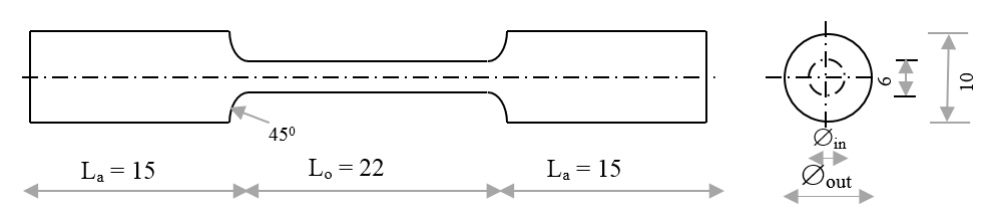
Figure 3: Tensile